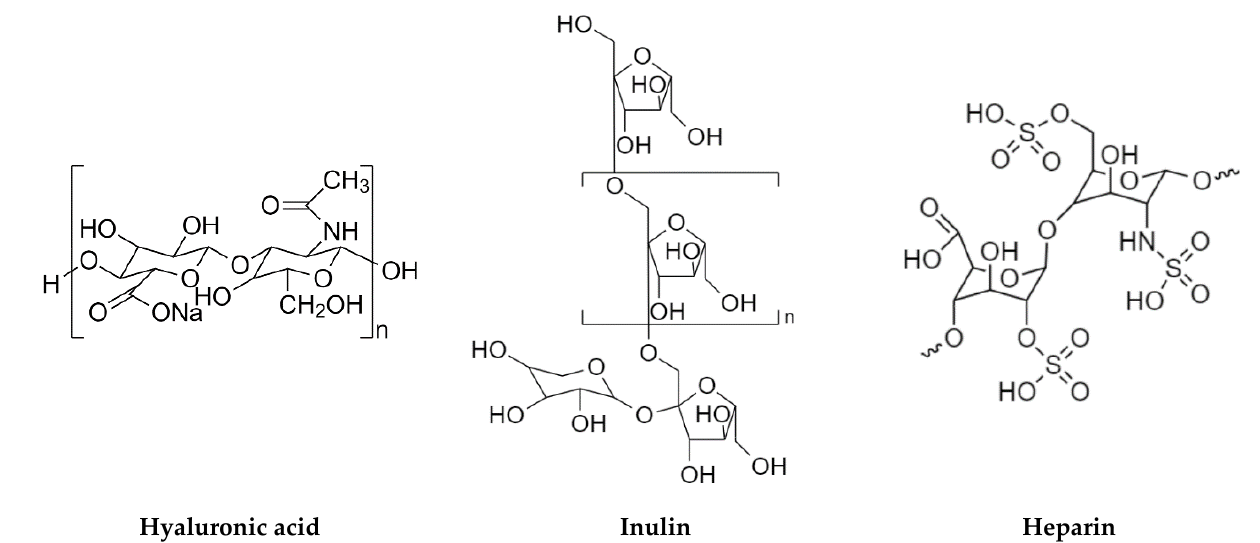
Figure 1. Structural formula of hyaluronic acid, inulin, and heparin.